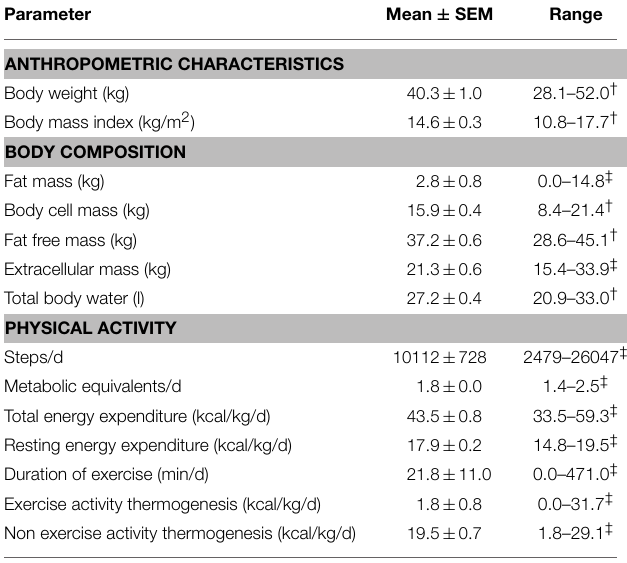
TABLE 3 | Anthropometric characteristics, body composition, and physical activity parameters in a population of anorexic patients with broad activity pattern.